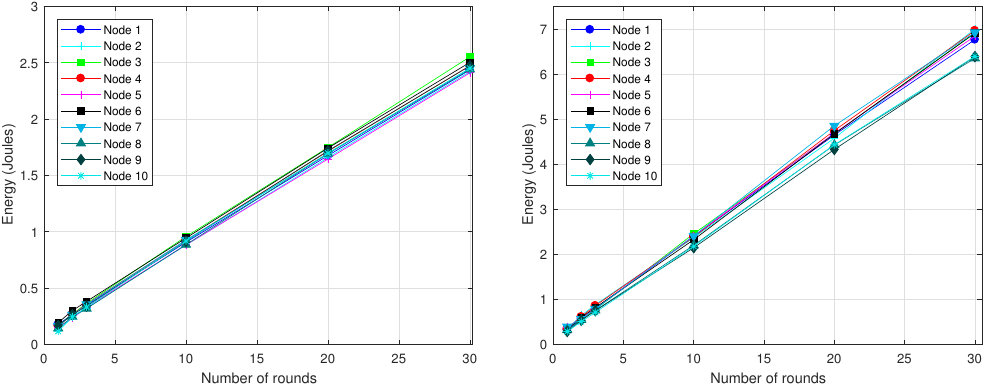
Figure 10. Energy consumption after the simulation of the 10-node topology, with DC = 3% ( left ) and DC = 10% ( right ), for 1, 2, 3, 10, 20 and 30